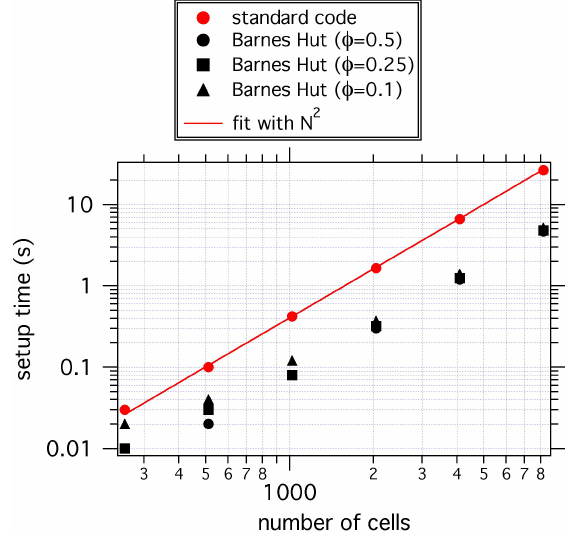
Fig. 4. Scaling of set-up time for boundary element calculations with the number of cells ( N ) used in the calculation. This plot shows how the observed time necessary to construct the stiffness matrix (e.g., Eq. 1), (setup time) increases with the number of cells N . Red symbols are for the standard implementation. The red line has a slope of 2 corresponding to scaling of N 2 . The black sym- bols define the scaling of setup for the BHM. The absolute setup duration is smaller for the BHM than for the standard approach.